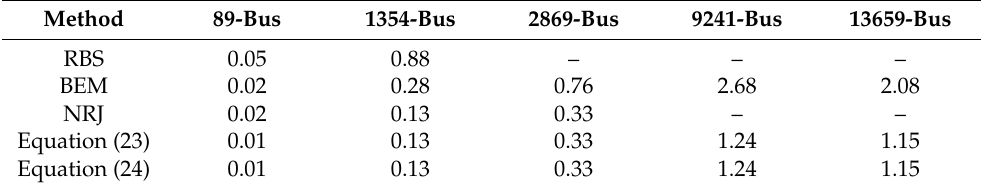
Table 6. Solution times(s) with reactive